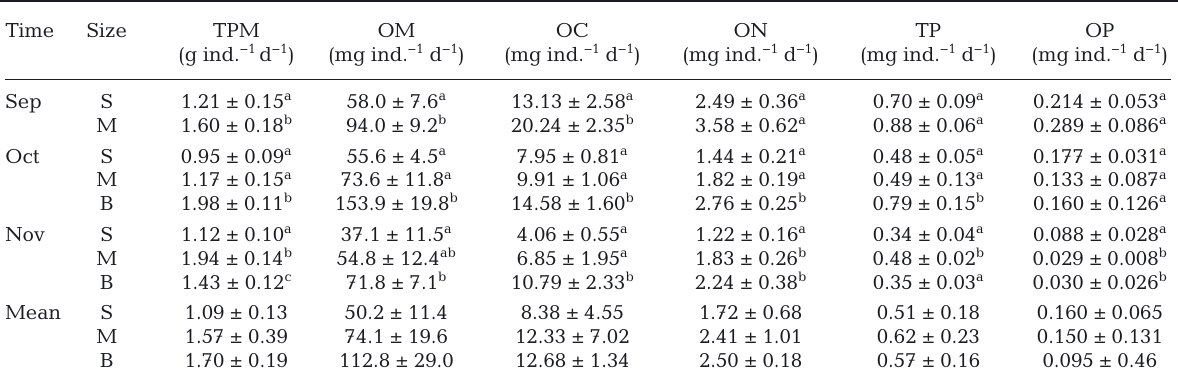
Table 7. Mean (±SD) standardized biodeposition rates for small (S), medium (M) and big (B) bay scallops during different months in Laizhou Bay. TPM: total particulate matter; OM: organic matter; OC: organic carbon; ON: organic nitrogen; TP: total phosphorus; OP: organic phosphorus. Different letters in the same month and column indicate significant differences (p <